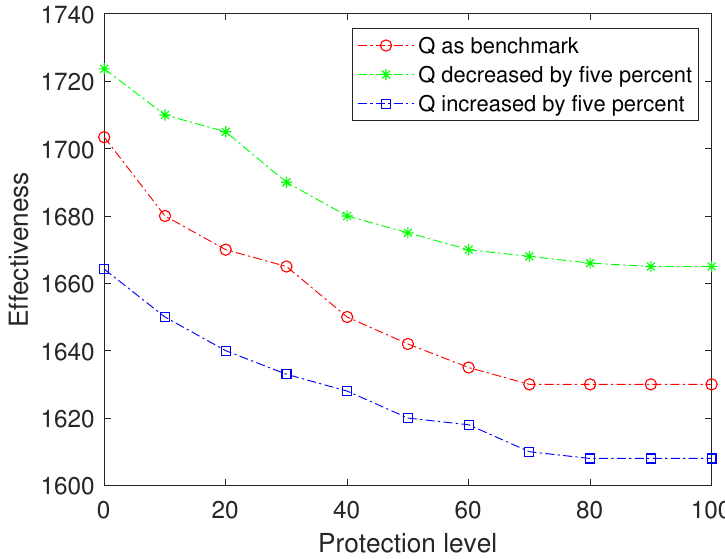
Figure 4. Effectiveness vs. quality